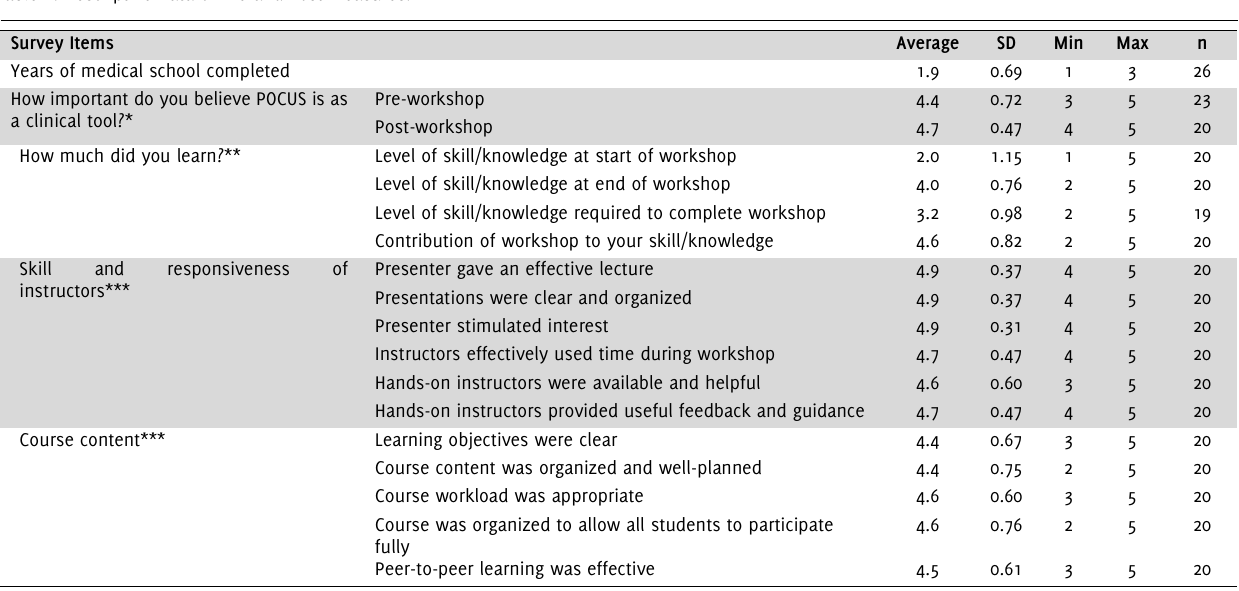
Table 1 . Descriptive Data of Pre-and